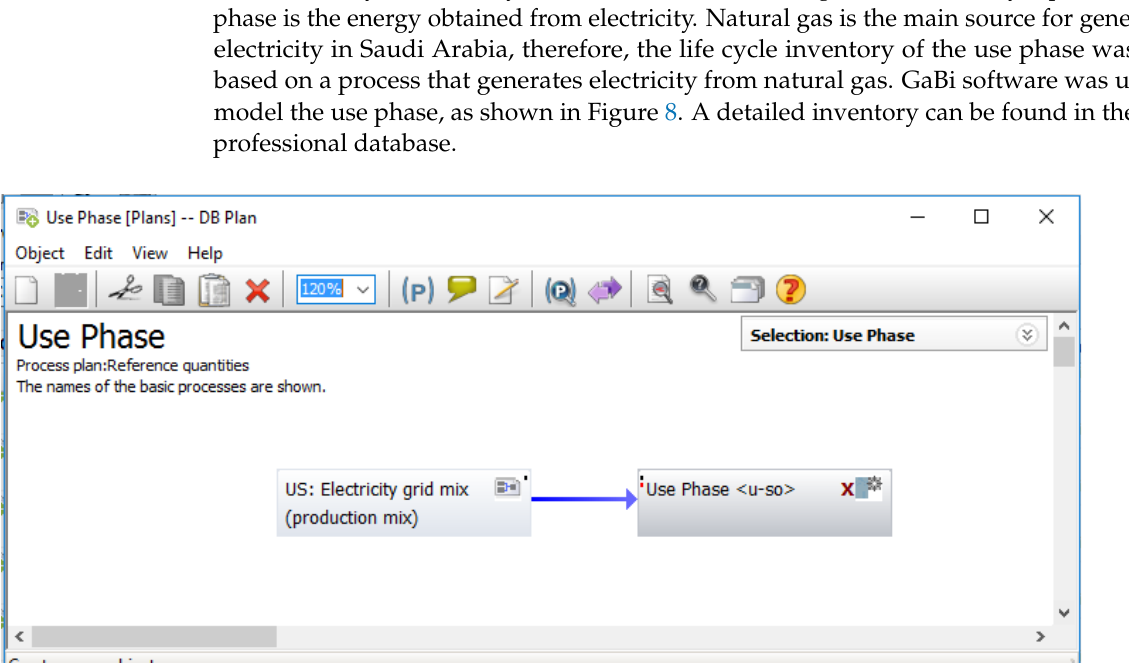
Figure 8. The use phase model using GaBi software.